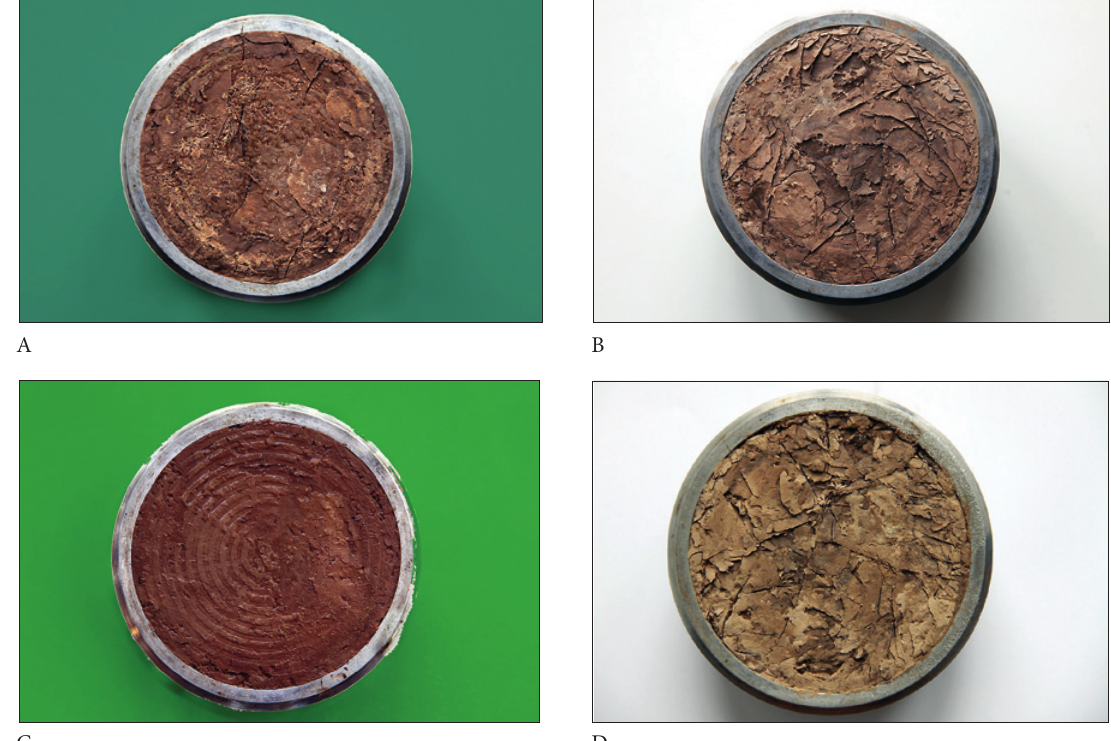
Fig. 4. Picture of the sample with the filtering chamber ring: A – after first freezing; B – after second freezing; C – after second filtration; D – after third freezing